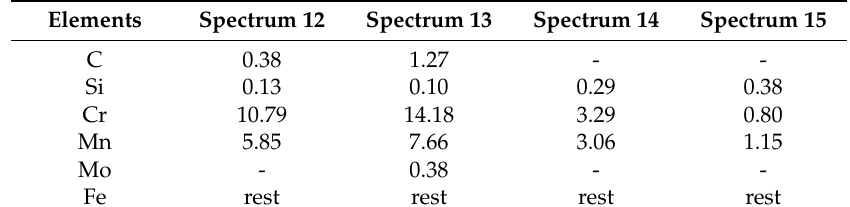
Figure 9. ( a ) Line scan in the microstructure after UFH; the darker feature corresponds to a carbide; ( b ) line scan diagram showing chemical heterogeneity. Table 2. Chemical analysis of spectrums shown in Figure 9a.